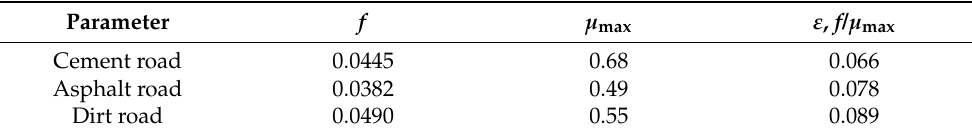
Table 2. Typical road parameters.